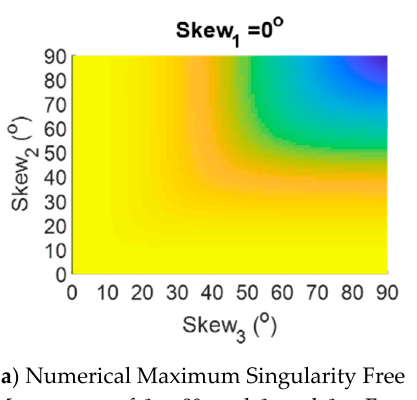
Figure 3. Maximum Singularity Free Momentum of β 1 = 90°, and β 2 , and β 3 = Free.